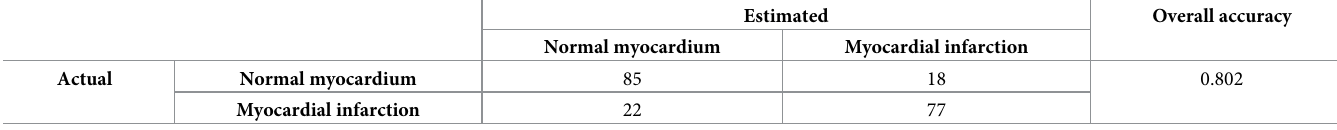
Table 5. Overall classification accuracy of the artificial neural network for the short-axis papillary muscle level images.